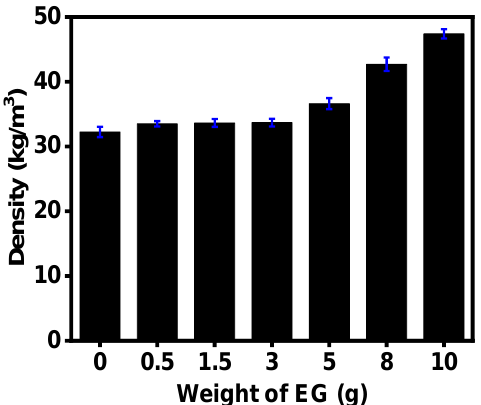
Figure 4. Fourier Transformed Infrared spectra for carvone, 2-mercaptoethanol, and carvone-based polyol.